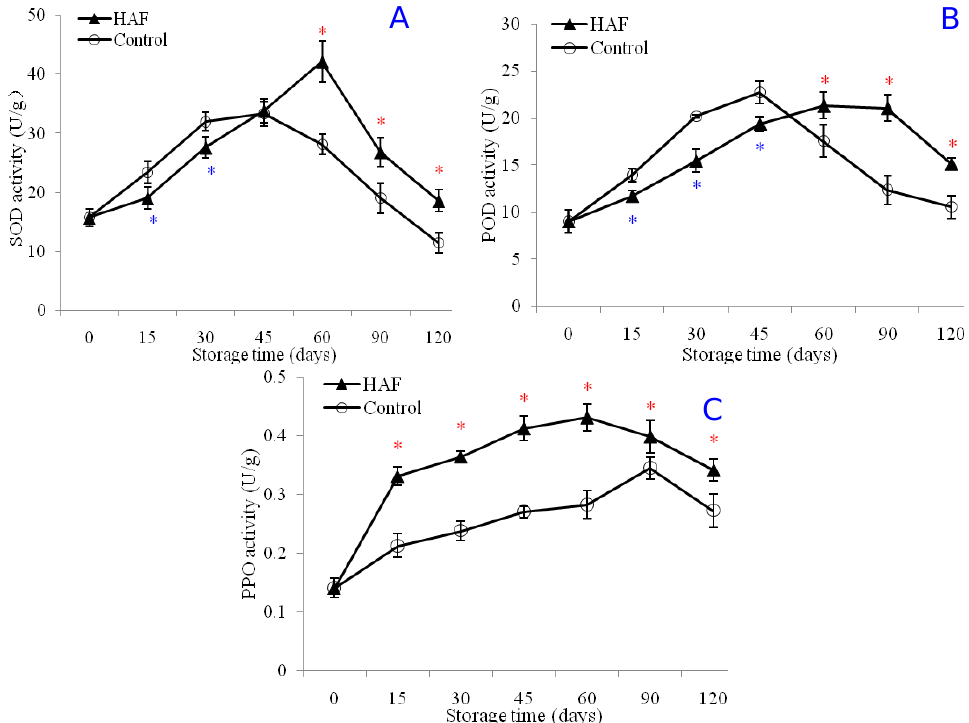
Figure 4. Effects of HAF on enzyme activities of SOD ( A ), POD ( B ), and PPO ( C ) of navel orange fruits during 120 days of cold storage at 6 °C. Each value was presented as the mean ± standard error (SE) of three replicates. The symbols * and * represent significantly higher and lower values, respectively, for the HAF-treated fruits than for the control fruits. The significant difference was determined according to the independent samples t -test ( P < 0.05) on each storage day.